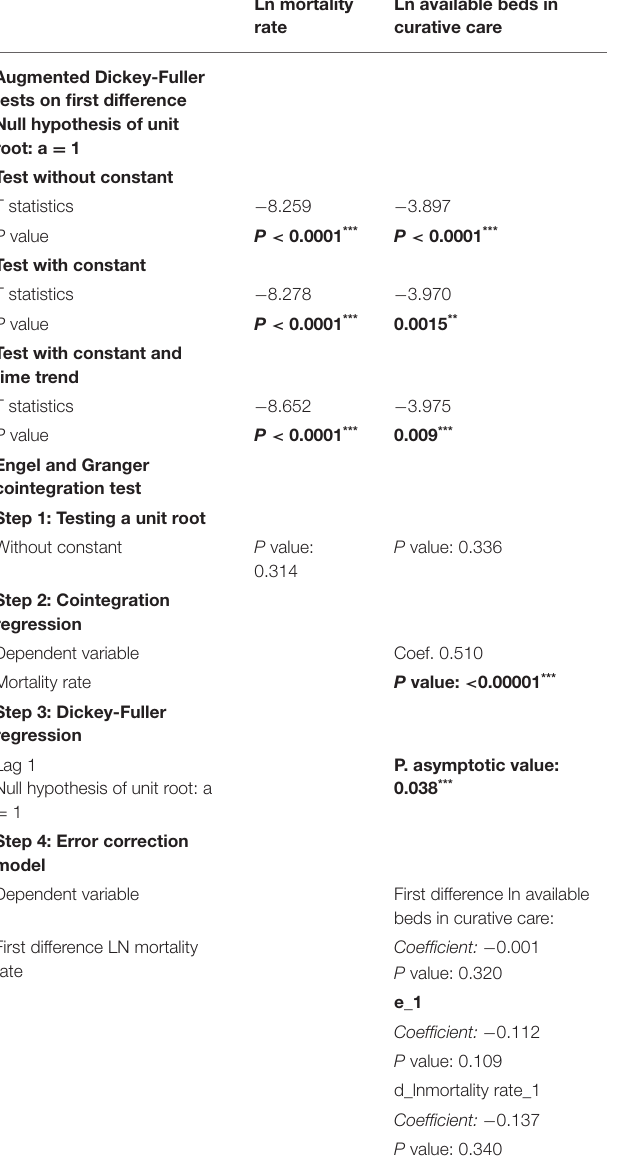
TABLE 6 | Engle Granger cointegration test between life expectancy and stay in hospitalization unit in the period 1970–2018. Ln life expectancy Ln stay in hospitalization unit Augmented Dickey-Fuller Tests on First